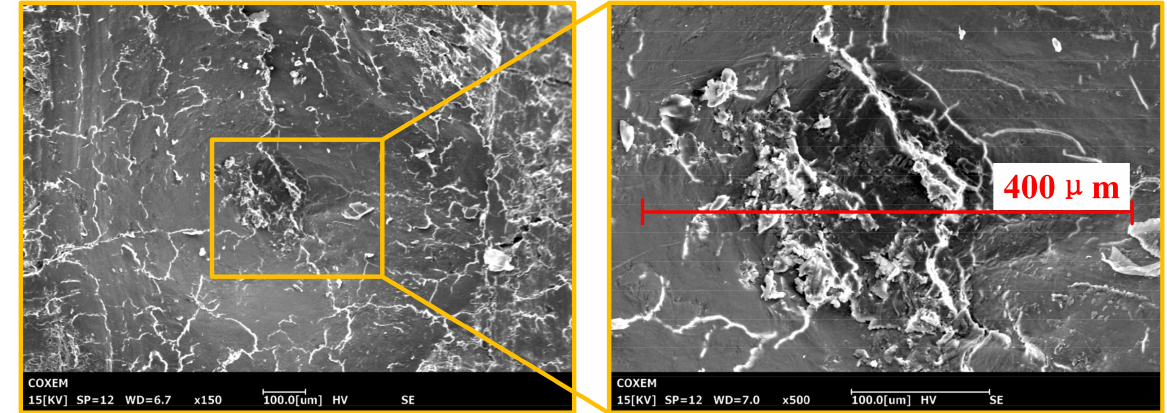
Figure 4. Morphology of indentation of the SPDT.